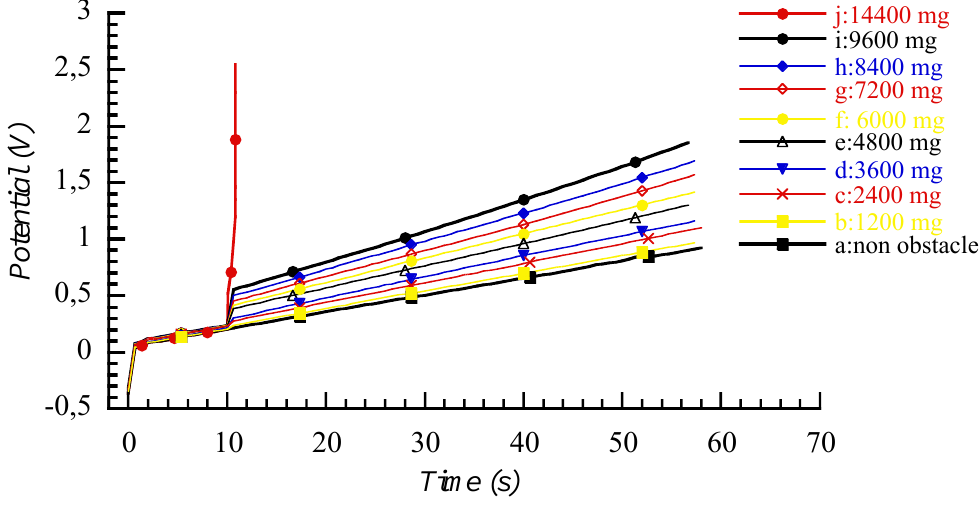
Figure 19. Chronopotentiograms obtained from a triple layer macroscopic muscle containing two polypyrrole fi lms [2 cm  1.5 cm  13 μ m] weighing 6 mg each, under fl ow . The muscle moves freely, contacting an obstacle after 10 s and of 5 mA in 1 M LiClO 4 sliding it for 3.5 s, overcomes its border and continues with a full angular movement of 108° (from –18° to +90°). The initial position is recovered by applying a current of –5 mA for 57 s. Obstacles weighing 1.2, 2.4, 3.6, 4.8, 6.0, 7.2, 8.4, 9.6 mg were slid, but the muscle was unable to push and slide an obstacle weighing 14.4 g (adopted from Reference [173] with kind permission from Wiley